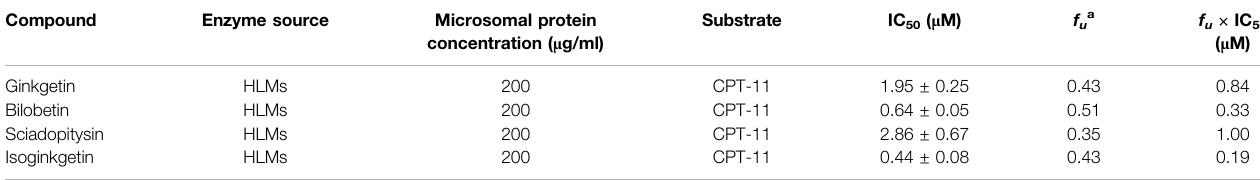
TABLE 1 | The inhibition parameters of four bi fl avones from Ginkgo biloba against CES2-catalyzed CPT-11 hydrolysis. Compound Enzyme